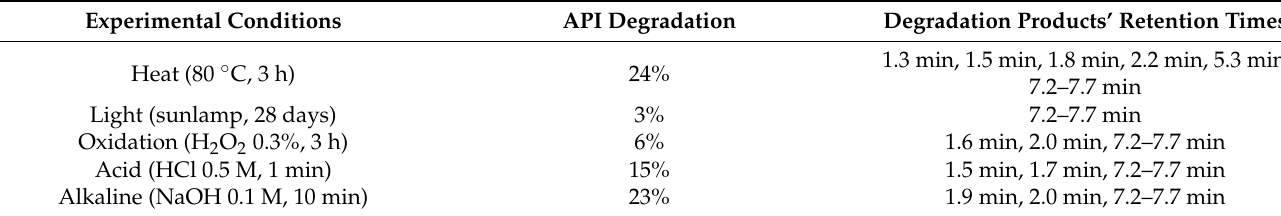
Table 3. N acetylcysteine forced degradation